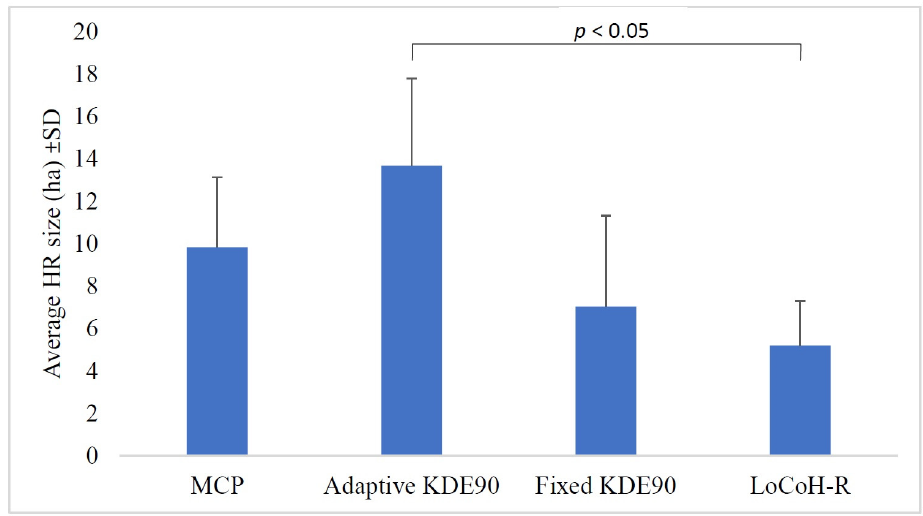
Figure 3. Average home range (HR) sizes calculated using the entire tracking dataset of all the years of tagged Caspian whipsnakes ( Dolichophis caspius ) in the study area estimated using four different methods. There was a significant difference between adaptive KDE90 and LoCoH-R ( p < 0.05).